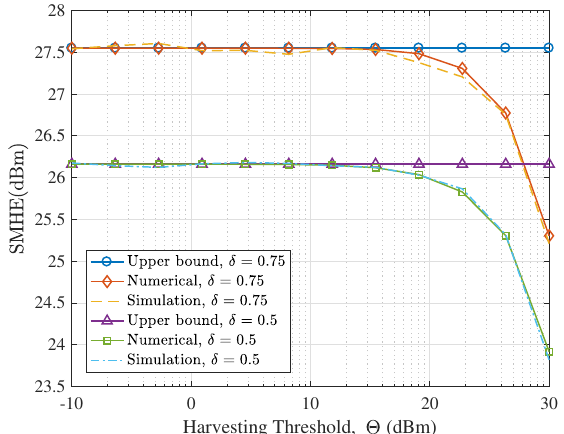
Figure 6. Spatial mean harvestable energy for LSWN-IC with λ t = 0.1, α = 4, η a = 1 and P et = 30 dBm.